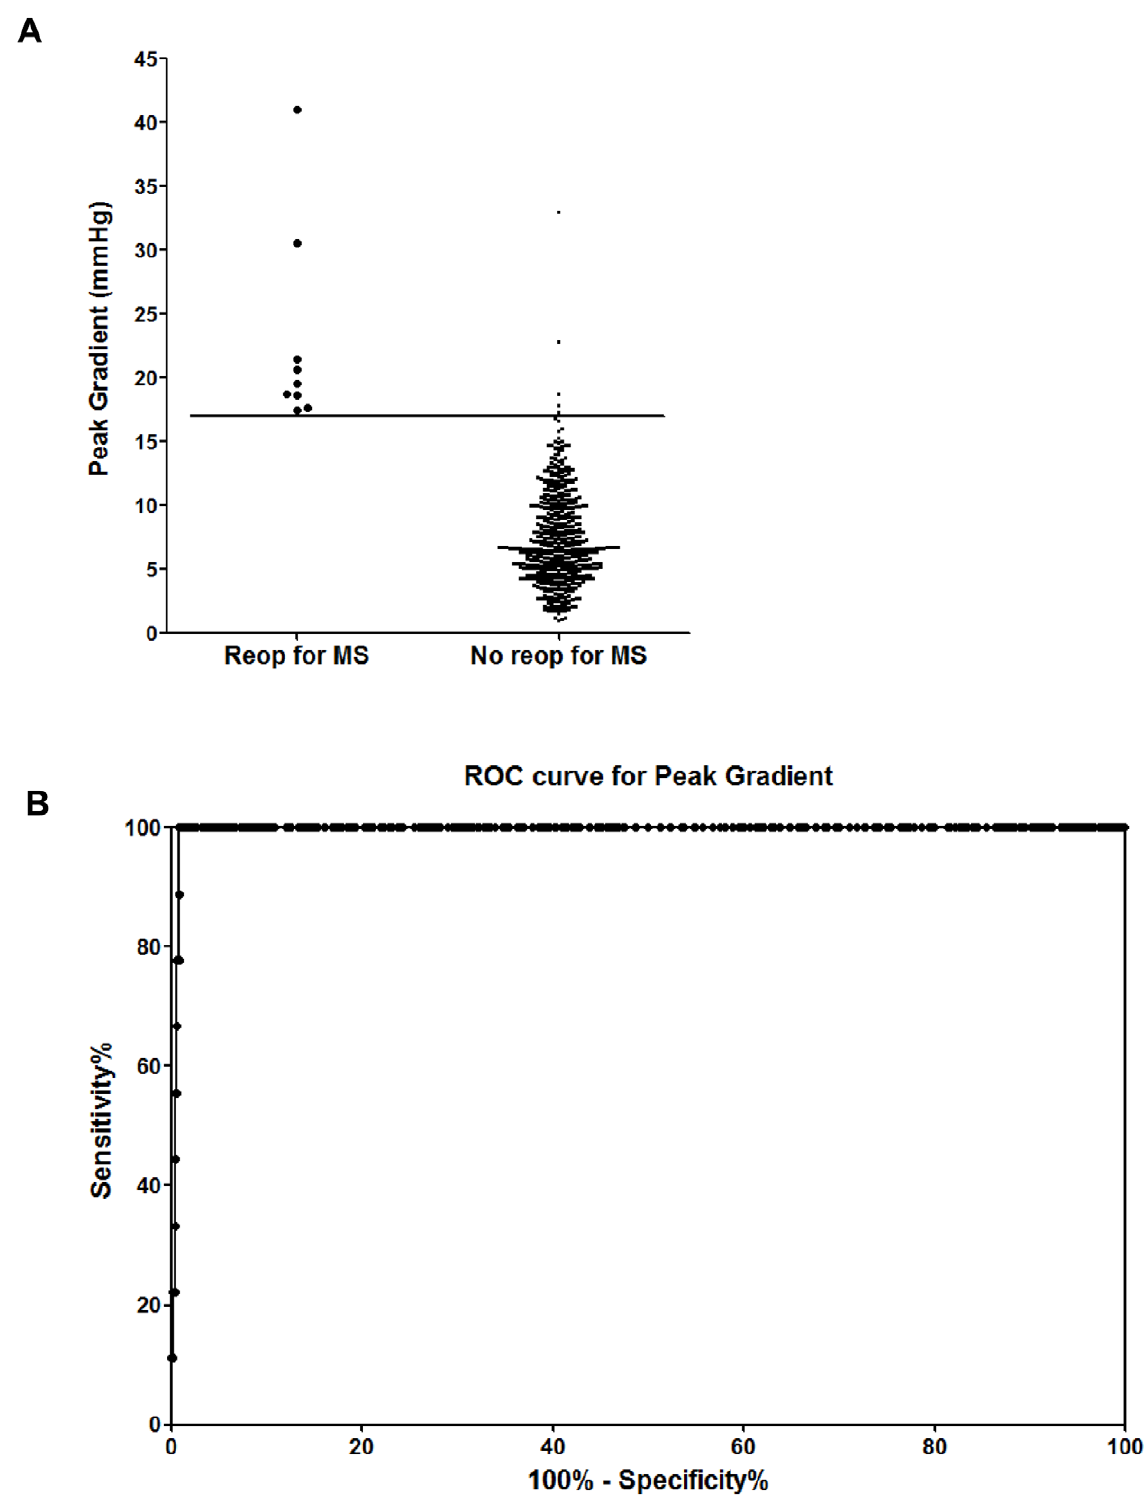
Figure 1. Distribution of peak gradients, split by the requirement for reoperation for mitral stenosis (MS). (A) A peak gradient of $ 17 mm Hg, best separated cases requiring reoperation for MS from those that did not. (B) Receiver operator curves (ROC) for peak transmitral pressure gradients. The area under the curve (AUC [SE]) for peak transmitral pressure gradients (0.996 [0.003]) showed strong discriminating ability.